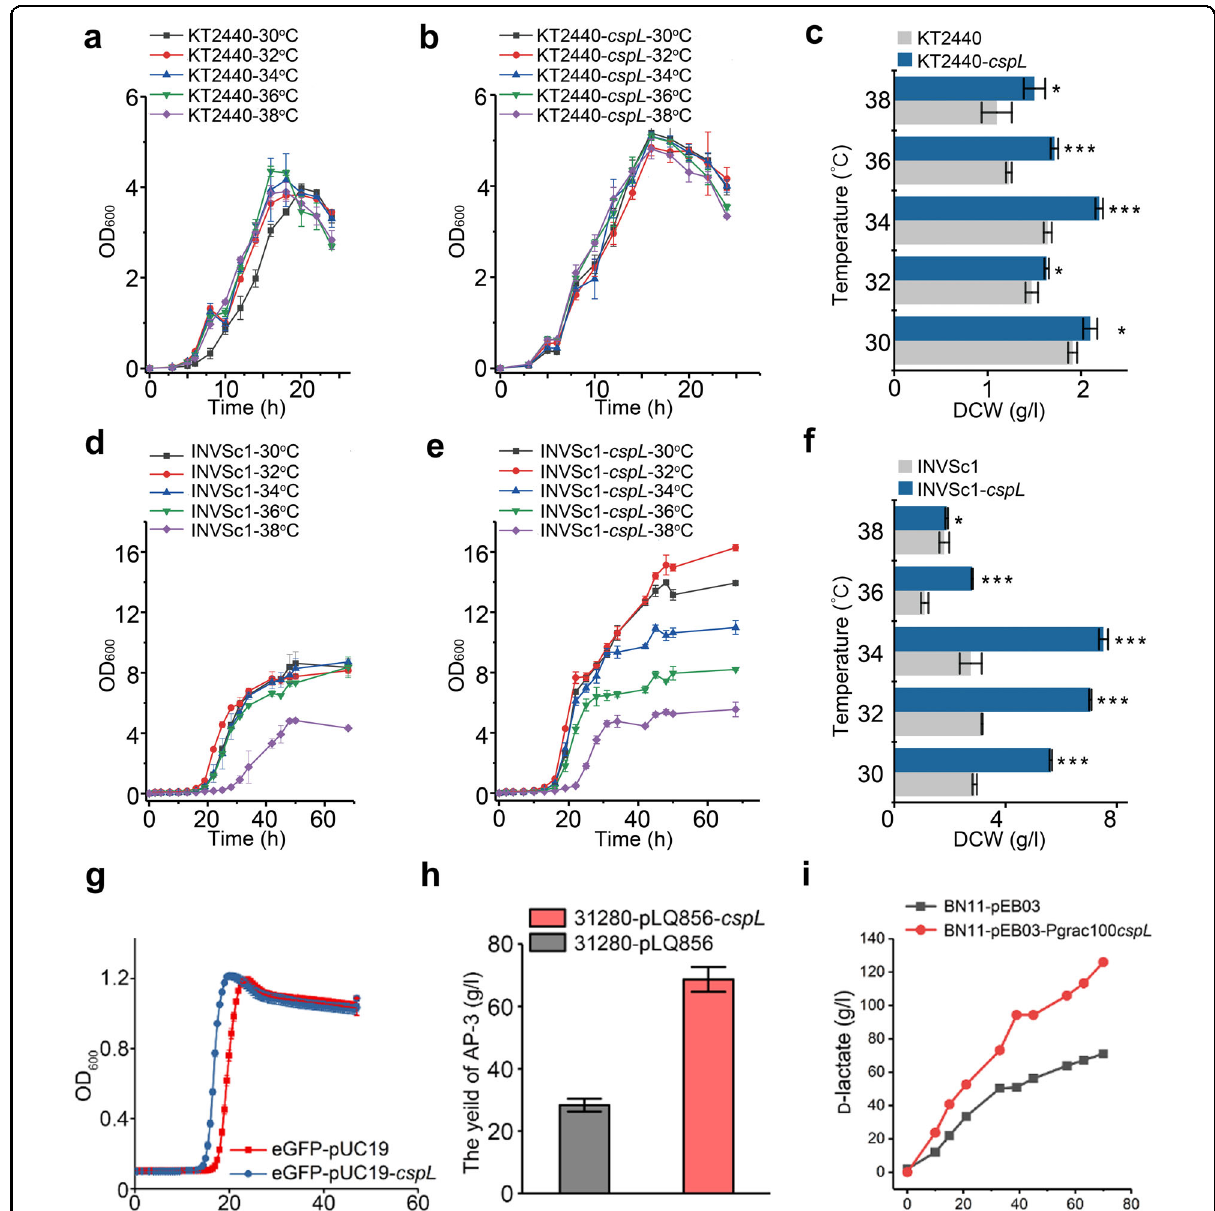
Fig. 6 Expression of the cspL gene promotes the growth of bacteria and fungi at high temperatures. a , b Cell growth curves of P. putida at different temperatures. c DCW of P. putida at different temperatures. Statistically signi fi cant differences between P. putida KT2440 and KT2440- cspL were observed at all temperatures tested. * P < 0.05 and *** P < 0.001 (two-tailed Student ’ s t -test). d , e Cell grow t h curves of S. cerevisiae at different temperatures. f DCW of S. cerevisiae at different temperatures. Statistically signi fi cant differences between S. cerevisiae INVSc1- cspL and the control were observed at all temperatures tested. * P < 0.05 and *** P < 0.001 (two-tailed Student ’ s t -test). g cspL improved growth of the eGPF expressing strain at 45 °C. The strain carrying cspL had a shorter lag phase. h HPLC analysis indicated that the production of AP-3 was increased by 160% from 29 ± 3 mg/l to 71 ± 6 mg/l in the culture of 31280::pLQ856- cspL . i Comparison of D -lactate production between B. licheniformis BN11-pEB03 ( fi lled square) and BN11-pEB03-Pgrac100 cspL ( fi lled circle). The growth of BN11-pEB03-Pgrac100 cspL showed an obvious advantage over BN11-pEB03.